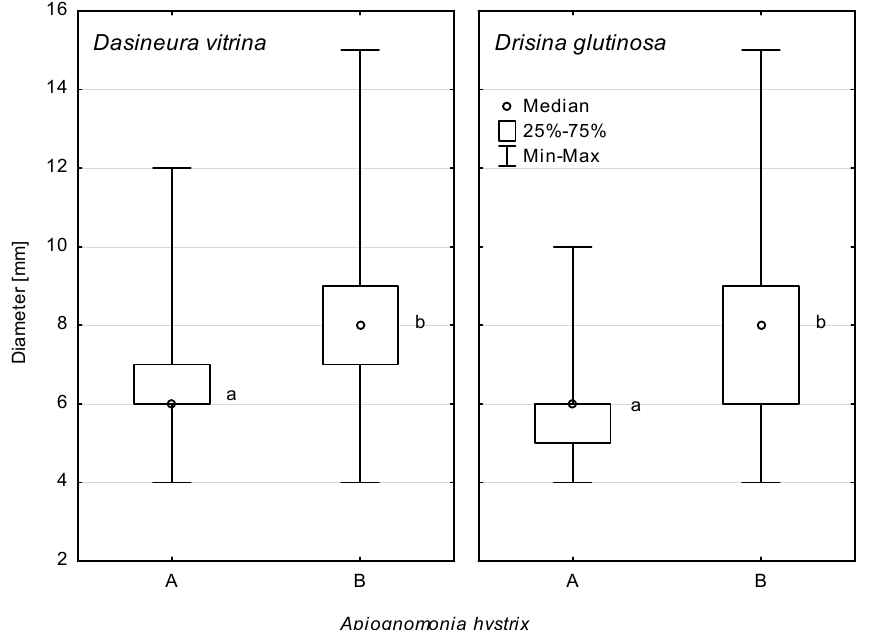
Figure 2. Diameters of necrotic lesions on leaves of Acer pseudoplatanus inhabited by Dasineura vitrina and Drisina glutinosa with (B) or without (A) co-occurrence of Apiognomonia hystrix infection. Values indicated with the same letters have been determined significantly not different at α = 0.05 in Mann–Whitney U test.